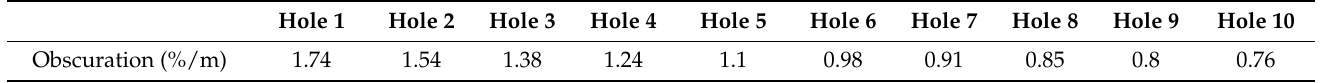
Table 4. The obscuration at ASD 1 when chamber obscuration is 10%/m.